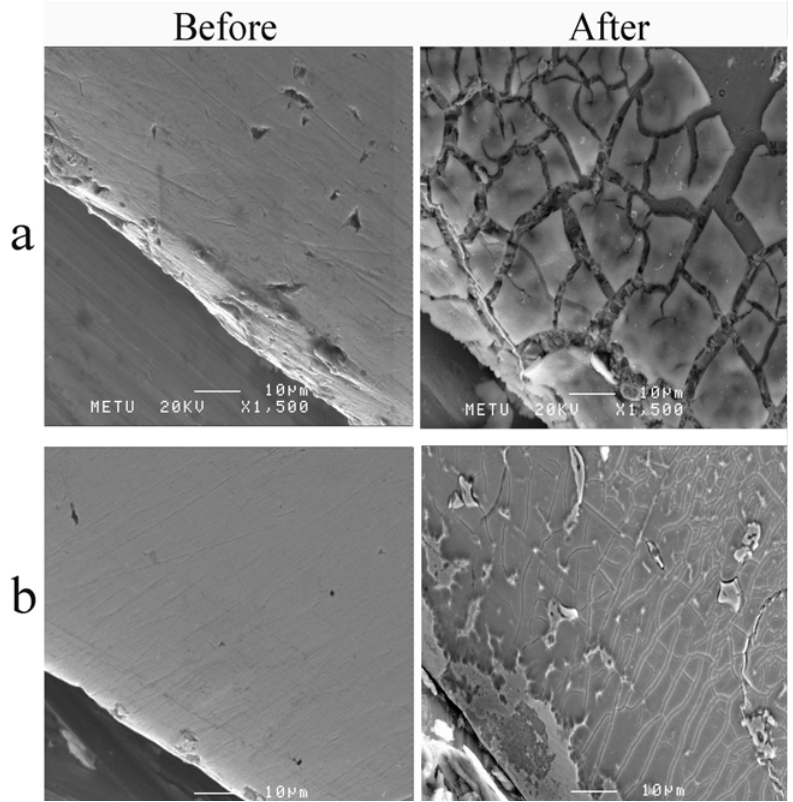
FIGURE 5- SEM images; before and after the potentiodynamic polarization tests (a) C1 (b)